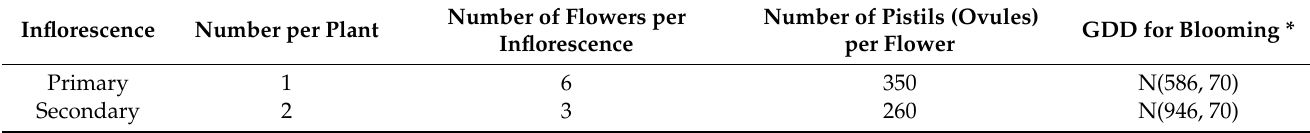
Table 1. Flower information of strawberry in the